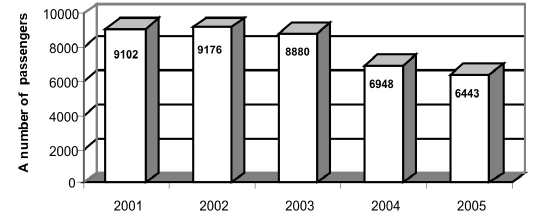
Fig 2. Dynamics of flows of passengers, transported to Poland ant from Poland by trains